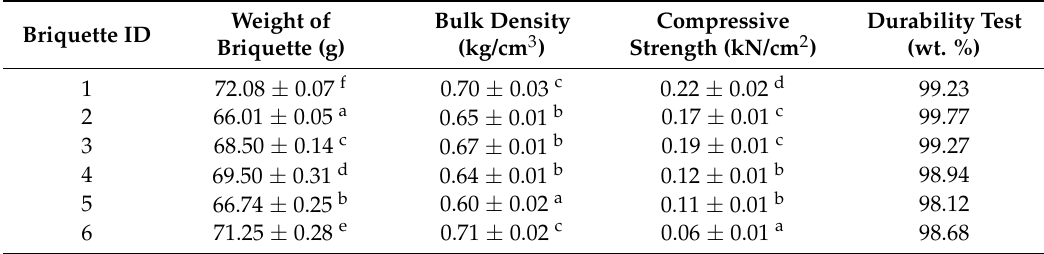
Table 5. Mechanical Properties of Briquettes Samples